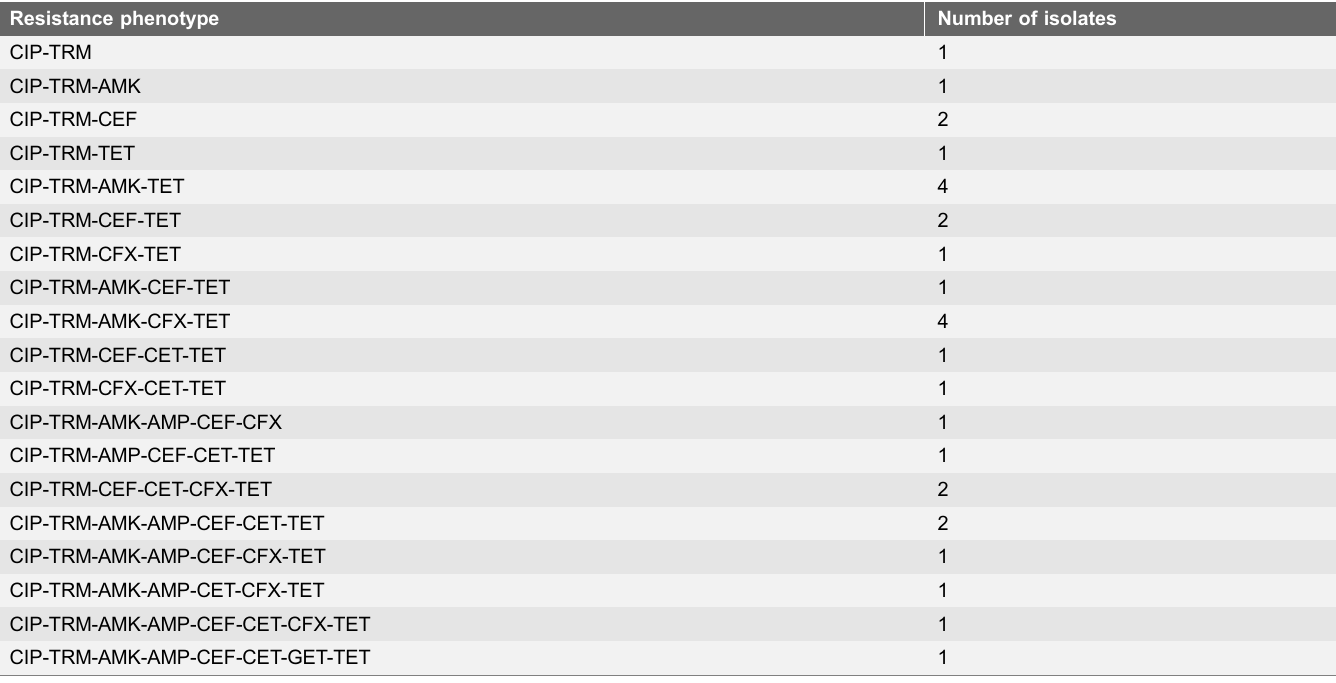
Table 2. Multidrug resistance profile of Faecalibacterium prausnitzii (n 5 29 isolates) isolated from feces of dairy calves and piglets. Resistance